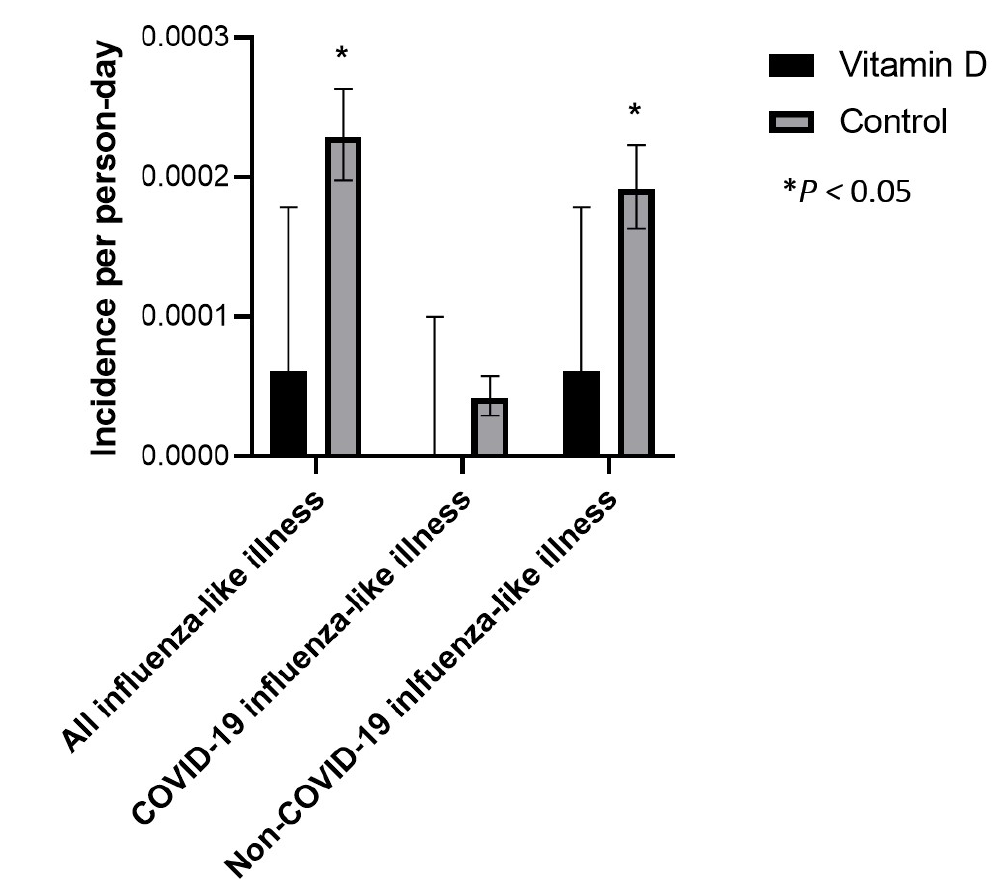
Figure 2. Incidence rate of influenza-like illness, COVID-19, and non-COVID-19 influenza-like illness in the vitamin D supplementation and control groups. 95% confidence intervals are based on the methods described by Sahai and Khurshid [41]. * p < 0.05. Table 4. Outcomes by vaccination status observation period.